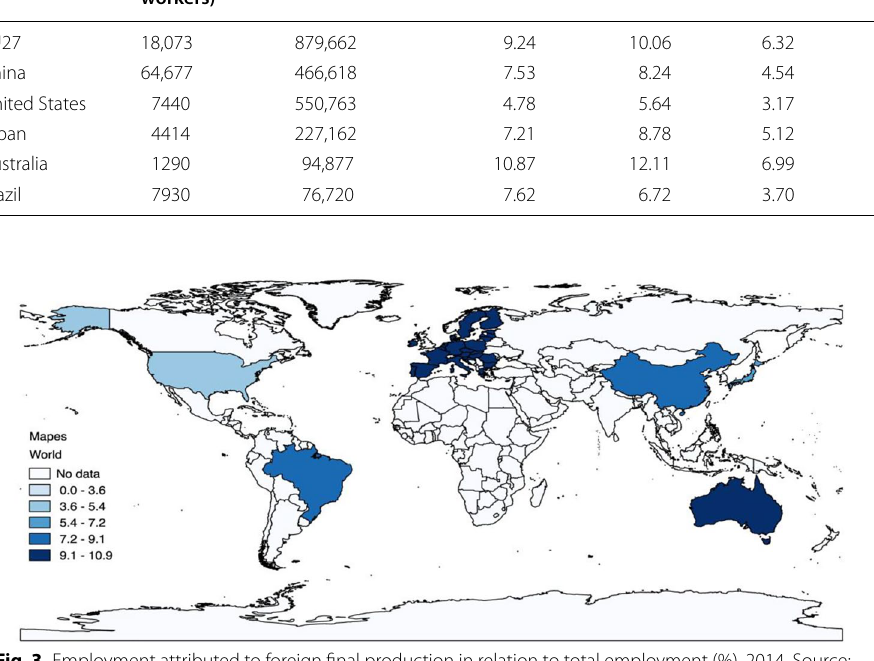
Fig. 3 Employment attributed to foreign final production in relation to total employment (%), 2014. Source: Author’s calculations based on the